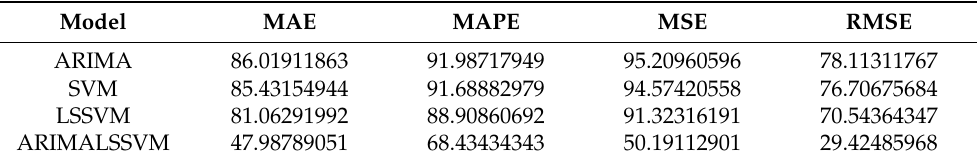
Table 10. Percentage improvement of the proposed models with other forecasting models (the COVID-19 cases of daily new recovered